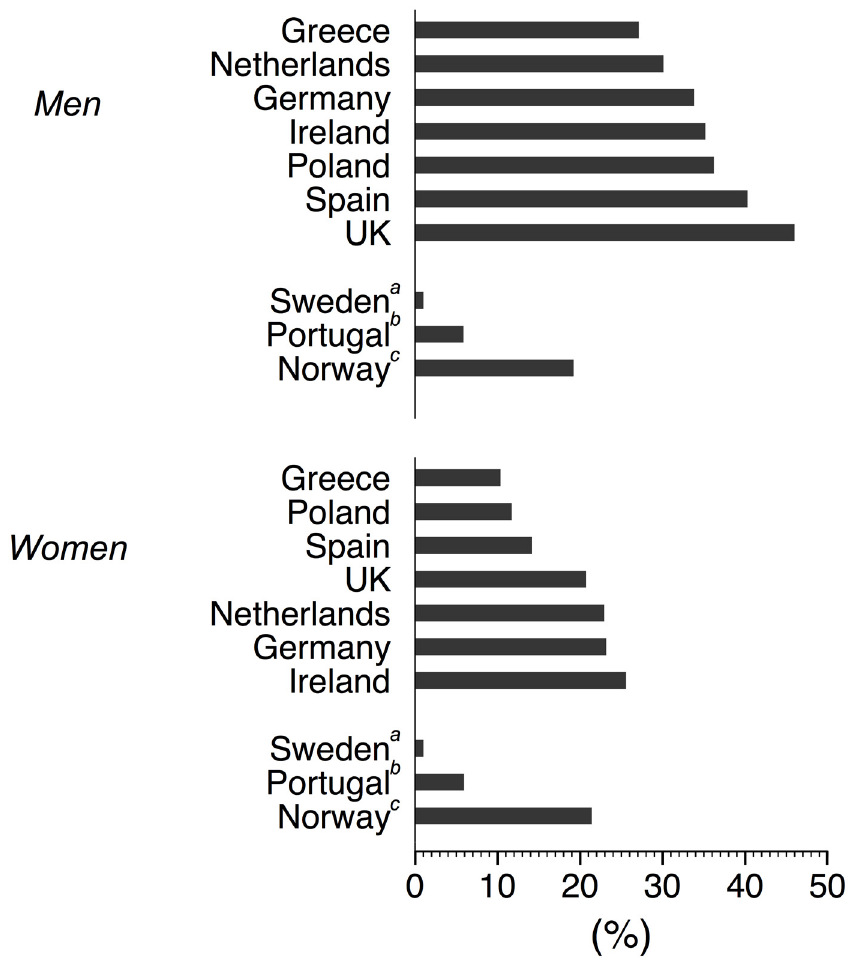
Fig 3. Proportion of subjects meeting the 30 min.d -1 Physical Activity (PA) recommendations by country. a Swedish data: Hagstömer et al. [18]; b Portuguese data: Baptista et al. [17]; c Norwegian data: Hansen et al. [19]; Prevalence estimates from the present study are adjusted for age, waist circumference, season, accelerometer wear time and smoking.